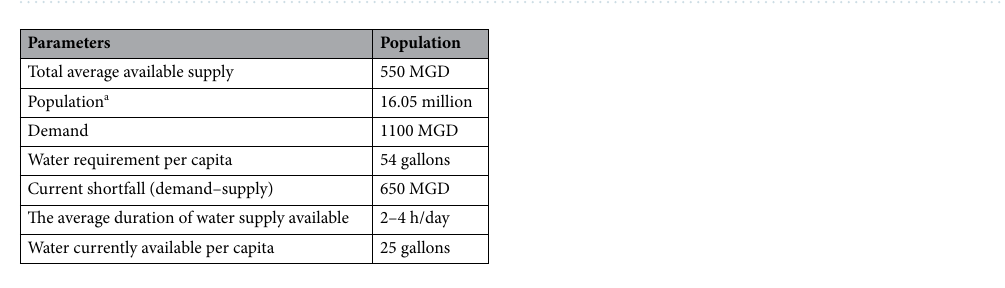
Table 2. Overview of water usage, demand, and availability in Karachi (Modified after Ashir and Khalid 84 ; KWASB). a Census, 2017, MGD: millions of gallons per day.